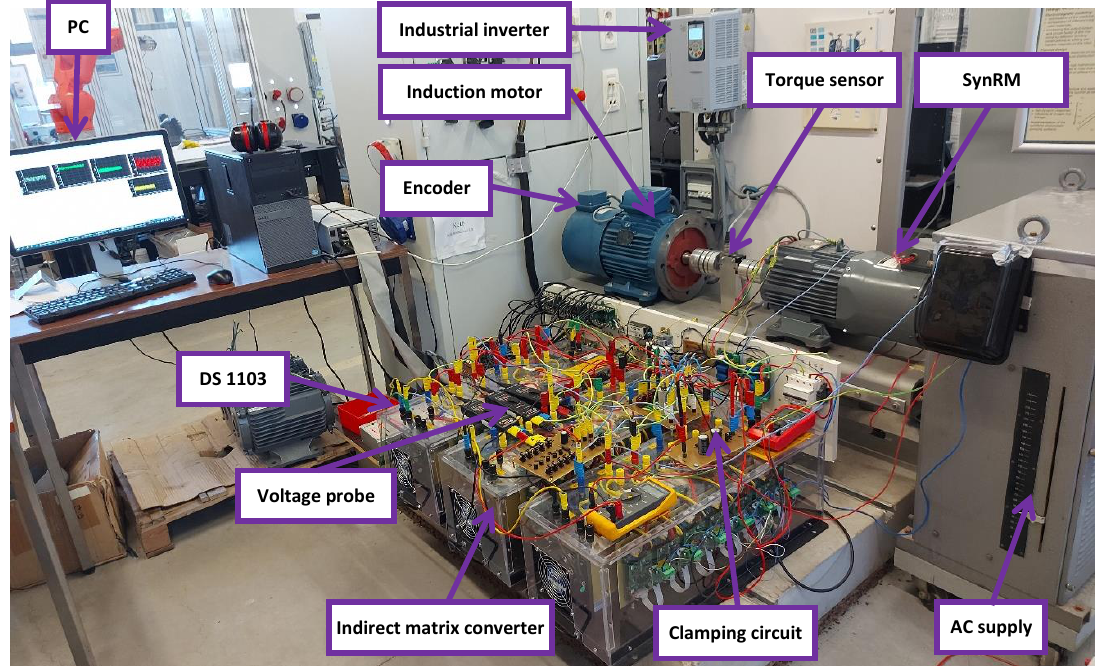
Figure 8. The setup used for experimental validation.